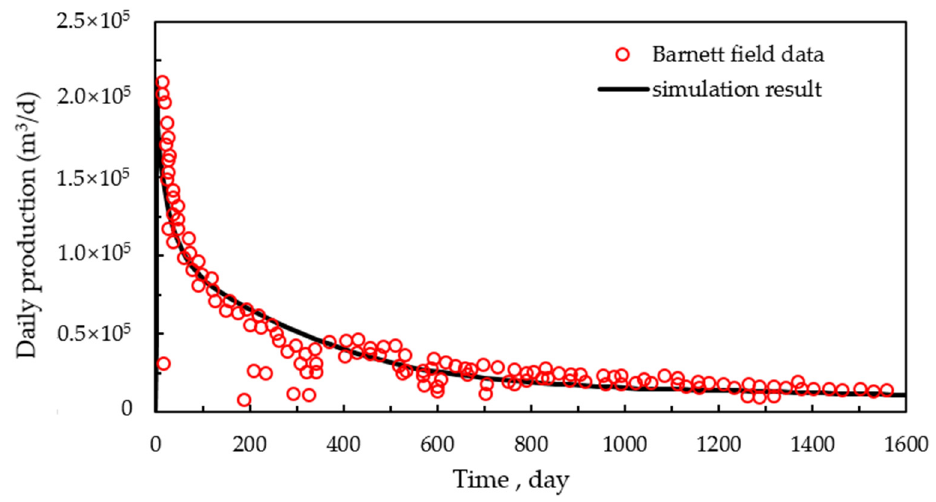
Figure 4. Comparison between field data and simulation results in Barnett Shale.